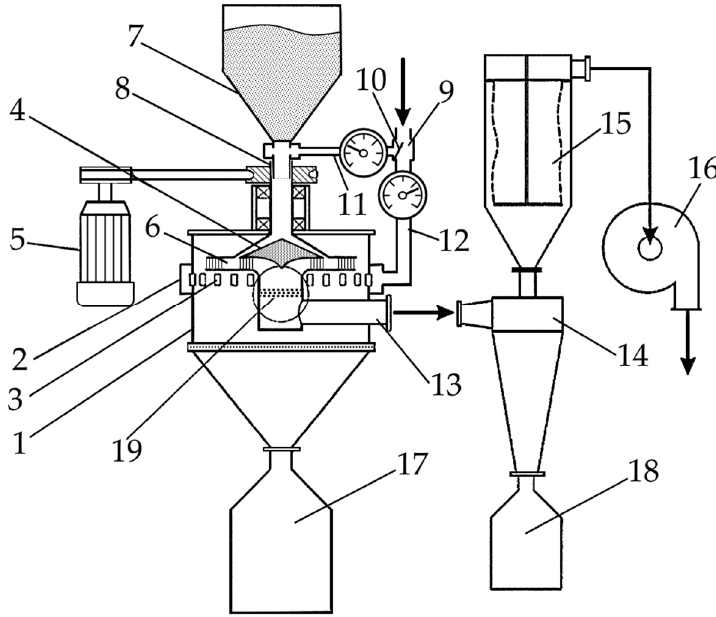
Figure 1. Appearance of the centrifugal air classifier.